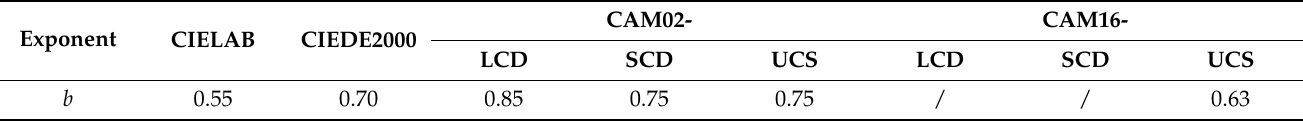
Table 2. Proposed values of exponent b for 2D samples in several color-difference formulas [8,26,27].